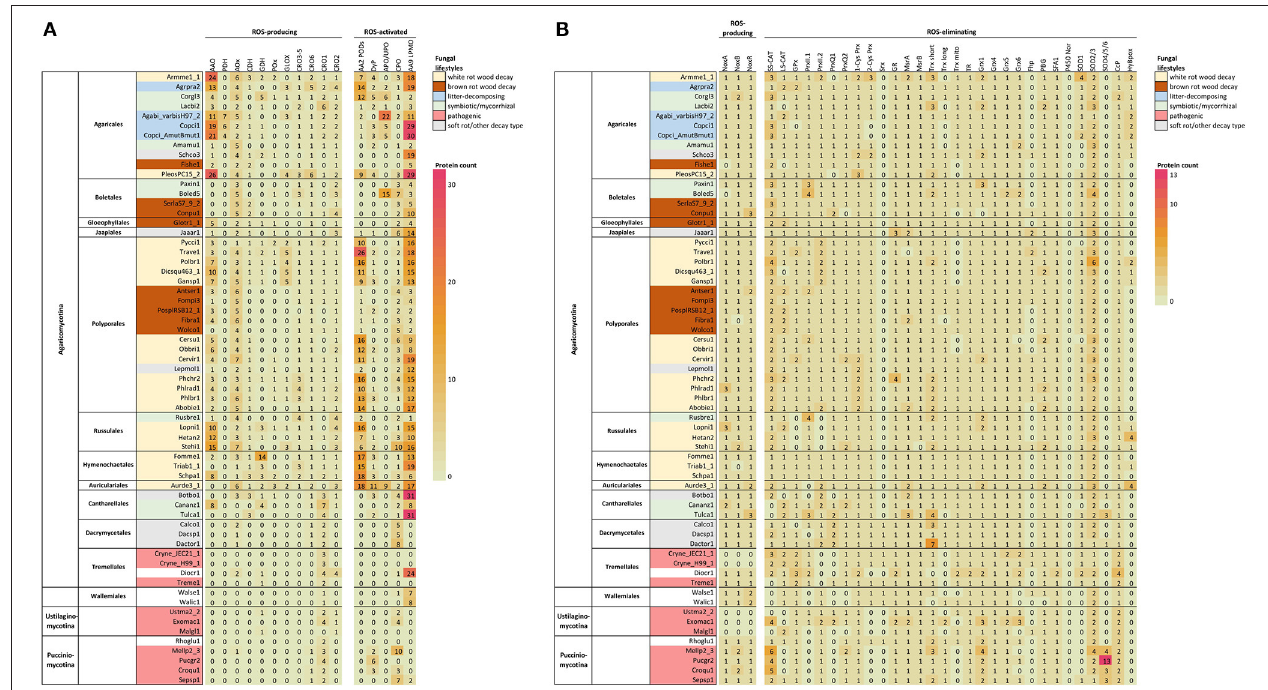
FIGURE 2 | ROS enzymes in Basidiomycota according to taxonomy. (A) Extracellular enzyme, (B) intracellular enzyme and protein encoding genes involved in ROS generation, utilization or quenching reactions. Fungal lifestyles are depicted in different colors (legend on the top right corner). Counts represent protein models in each genome available at JGI MycoCosm ( Supplementary Table 1 ). Genome & species coding: opened in Supplementary Table 2 .